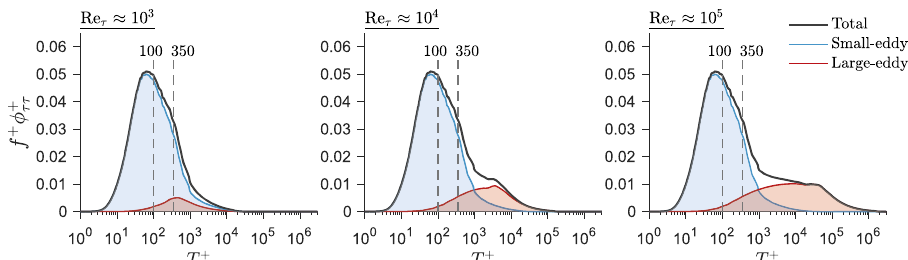
Fig. 2 Wall stress spectrum dependence on Reynolds number. Pre-multiplied spectra of the wall stress τ w with inner-scaling without actuation at Re τ ¼ 10 3 ; 10 4 ; and 10 5 obtained from predictive models 20 − 22 . The blue-shaded region is the Reynolds number invariant small-scale contribution and the red-shaded region is the contribution from outer-region large-scale structures, which is dependent on Reynolds number. The abscissa for T + = 100 and T + = 350 are indicated on each of the plots by the vertical dashed lines to indicate the nominal peak intensity of the small-scale contribution and threshold between large- and small-scale contributions,